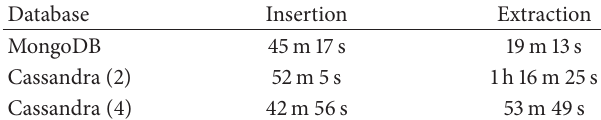
Table 3: PostgreSQL and Cassandra results.